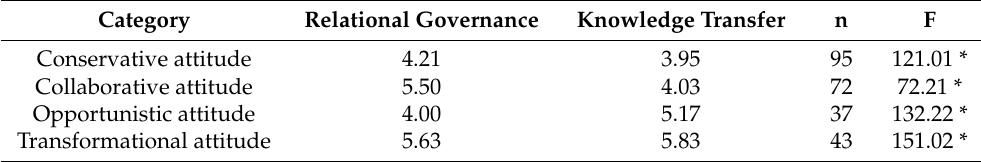
Table 5. Reliability and validity.